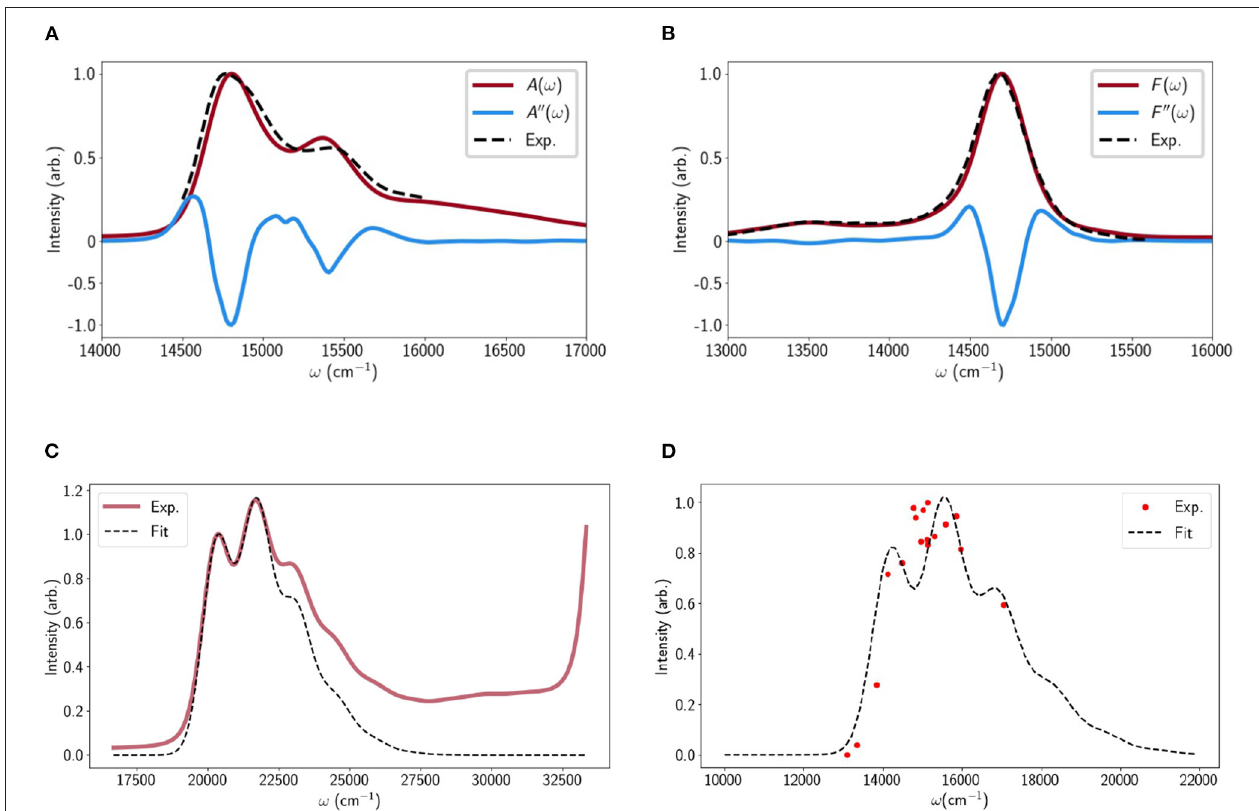
FIGURE 1 | (A) Calculated linear absorption spectrum of LHCII derived from one of the minima (red line) compared to the experimental spectrum (dashed line) (Krüger et al., 2010 ). The second derivative of the calculated absorption is shown (blue line) to highlight the Chl a and b peaks. The calculated spectra were essentially identical for all LHCII minima probed. (B) Calculated and experimental fluorescence profiles. (C) The calculated (dashed line) and measured linear absorption spectra of Lut in pyridine. (D) The calculated (dashed line) and measured (red dots) ( Walla et al., 2002) TPE spectrum of Lut. All calculation parameters were taken from the TA fit apart from a 150cm − 1 blue-shift to account for the fact that the TPE measurements were performed in